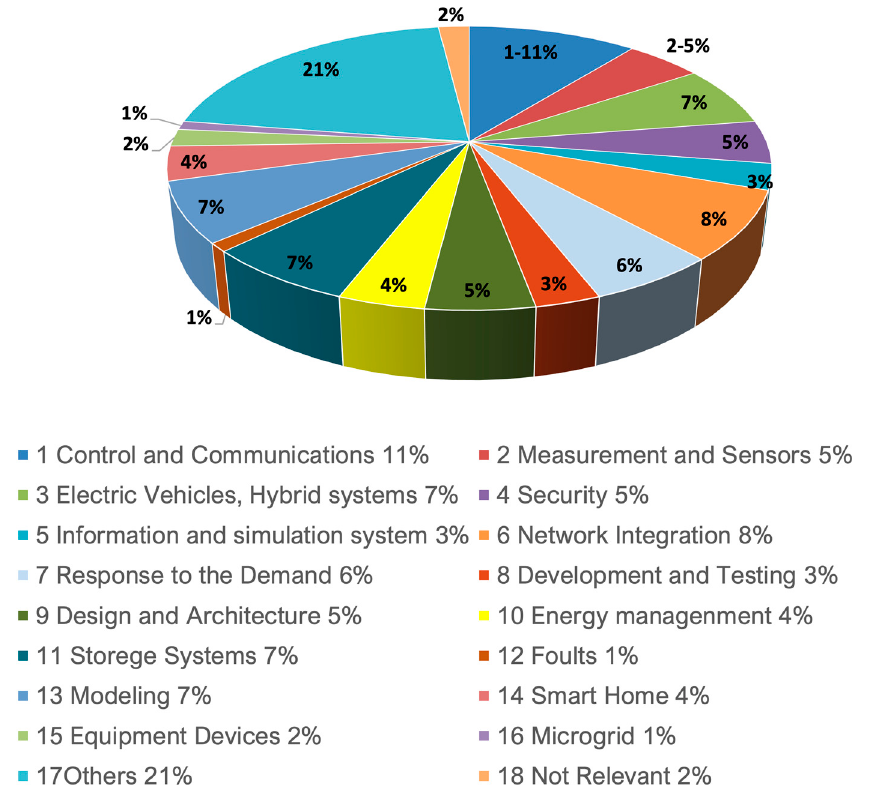
Figure 3. Technologies and developments related to Smart Grids [38]. Table 1. Summary of the projects related to smart grids.